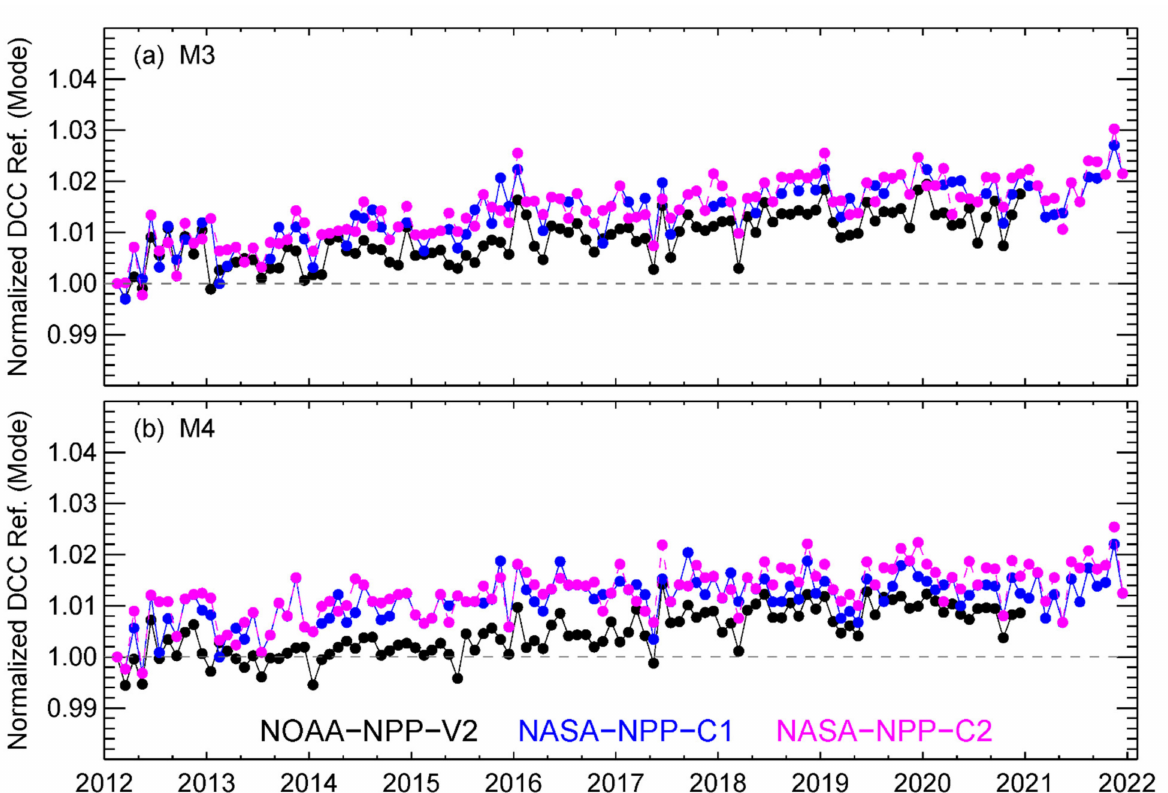
Figure 2. Normalized monthly DCC time series for S-NPP VIIRS bands ( a ) M3 and ( b ) M4. All data points are normalized to February